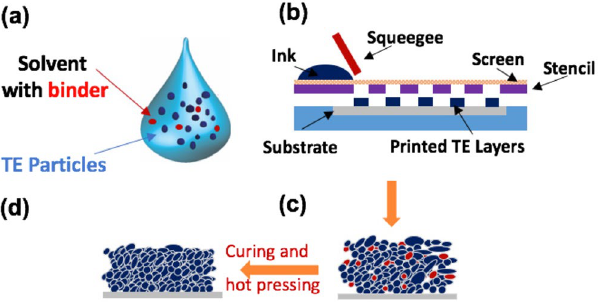
Figure 1. Schematic illustrations of ( a ) printable ink, ( b ) screen printing, ( c ) a screen-printed thermoelectric layer and ( d ) a hot-pressed layer after